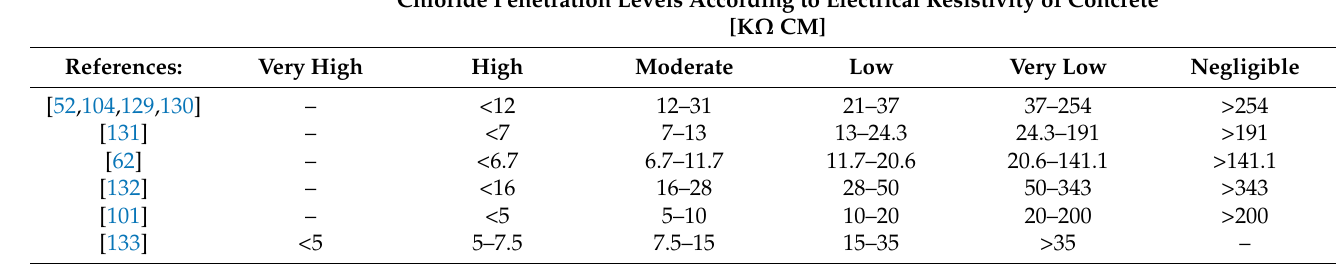
Table 5. Range of electrical resistivities at a different level of chloride penetration. Chloride Penetration Levels According to Electrical Resistivity of Concrete